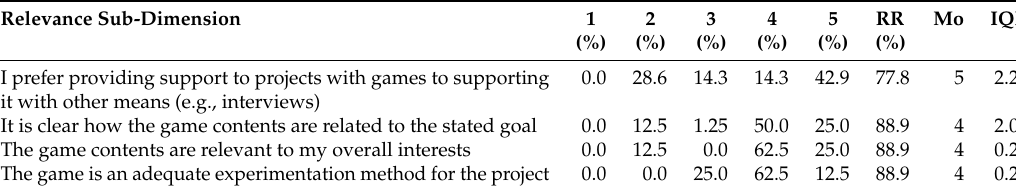
Table A5. MARISA Game